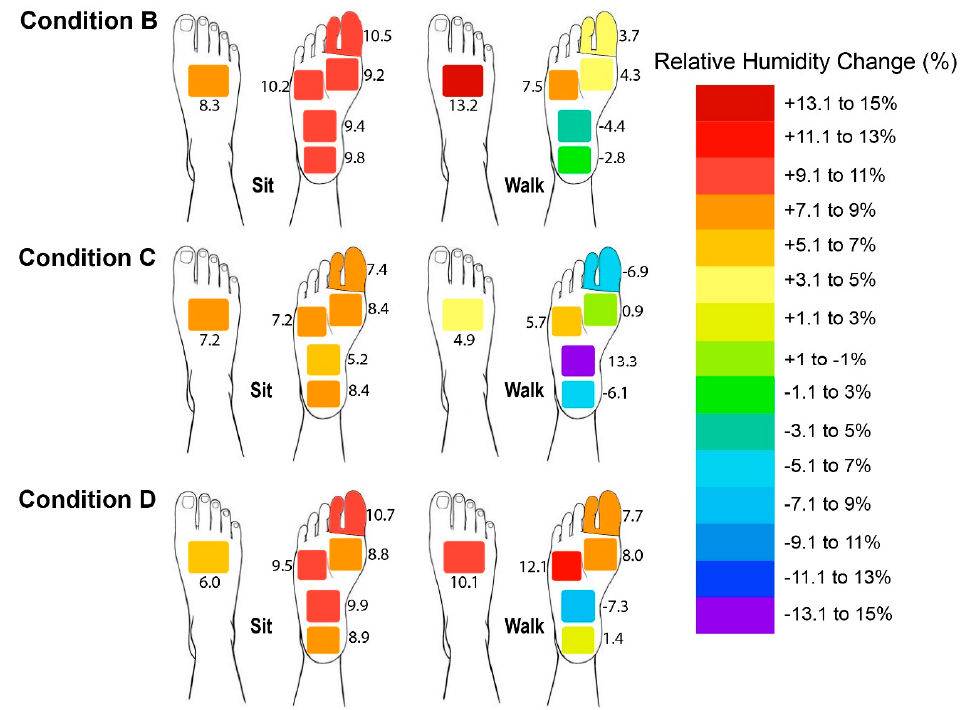
Figure 7. Changes in foot skin relative humidity at plantar (HP1–HP5) and dorsal (HD1) sides of foot after sitting and walking, where B: leather sports shoes, C: mesh sports shoes, and D: closed-toe slipper.